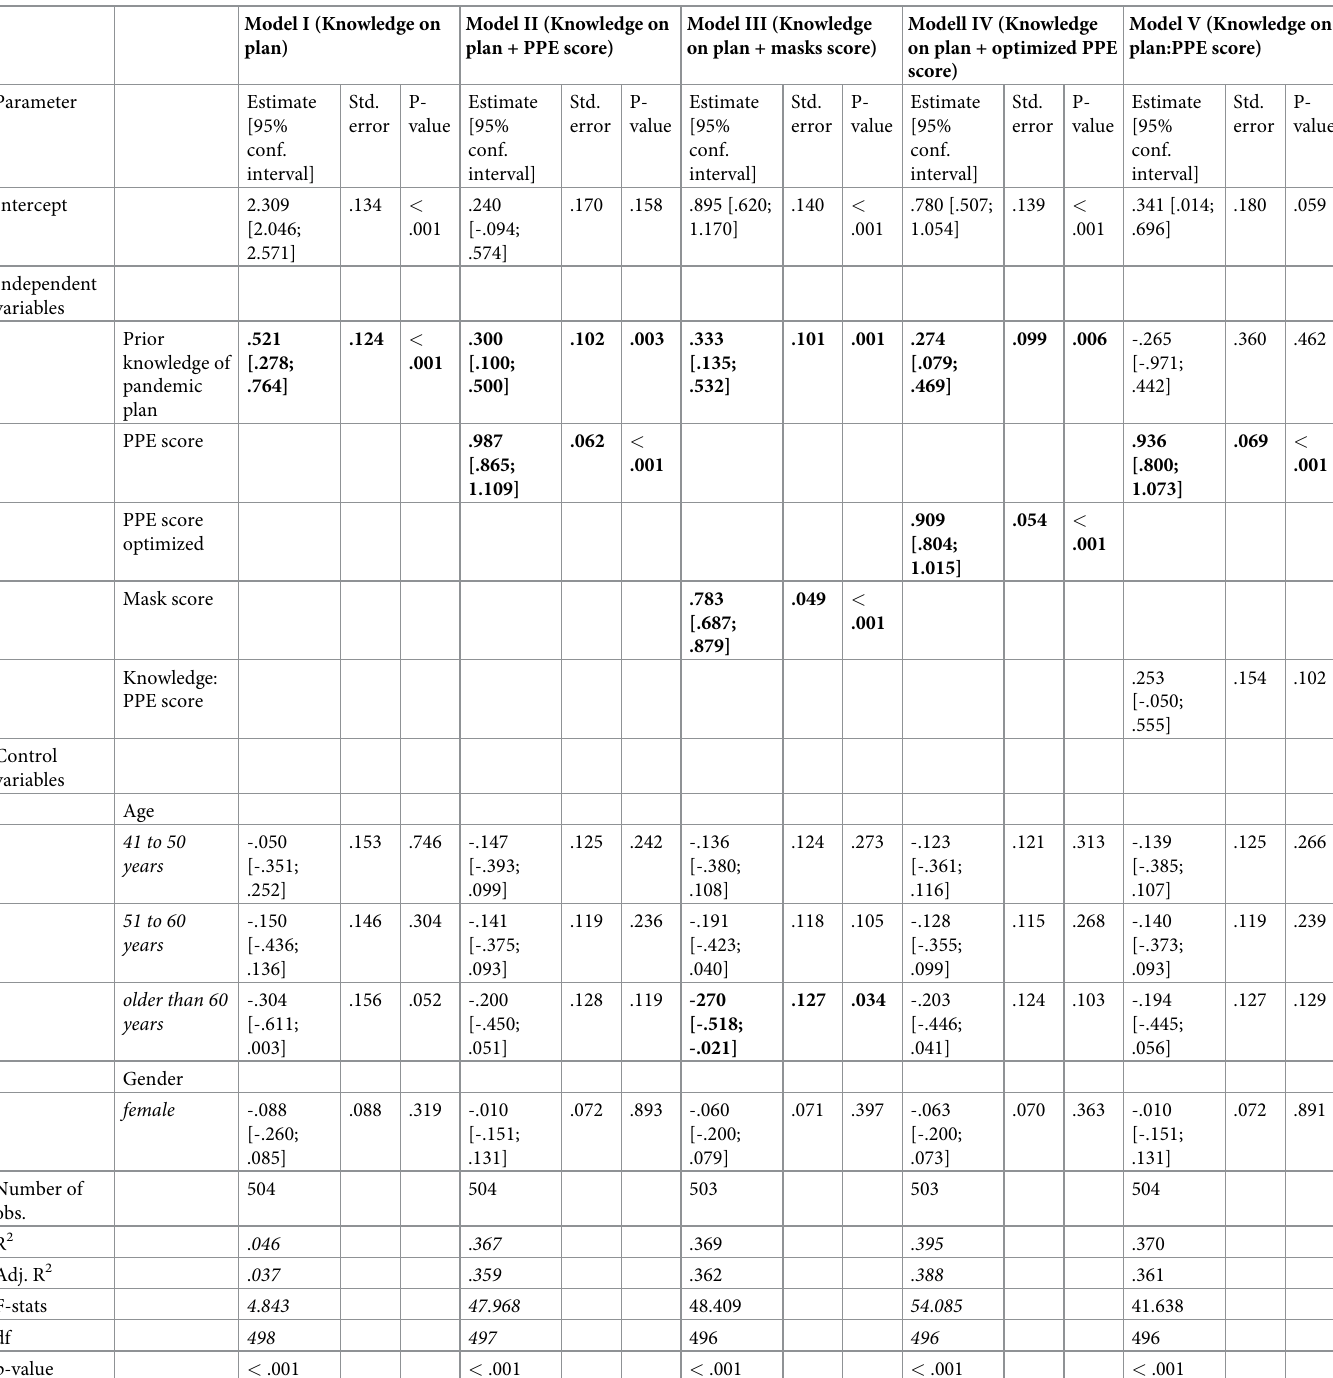
Table 4. Multivariable linear regression model on knowledge of a pandemic plan and pandemic preparedness among general practitioners. Model I (Knowledge on